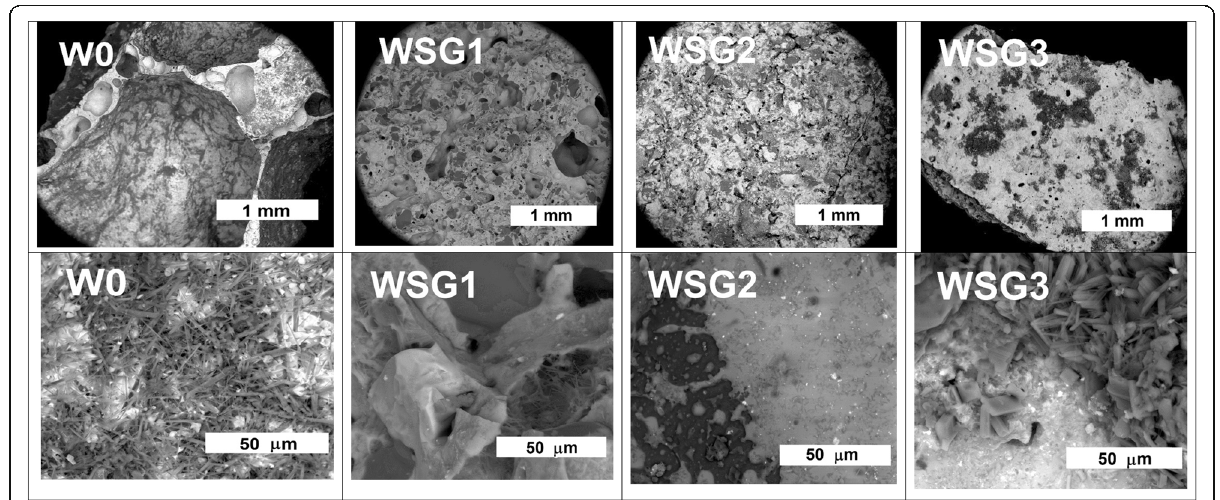
Fig. 3 SEM micrographs of W0, WSG1, WSG2, and WSG3 samples sintered at 900 °C/2 h